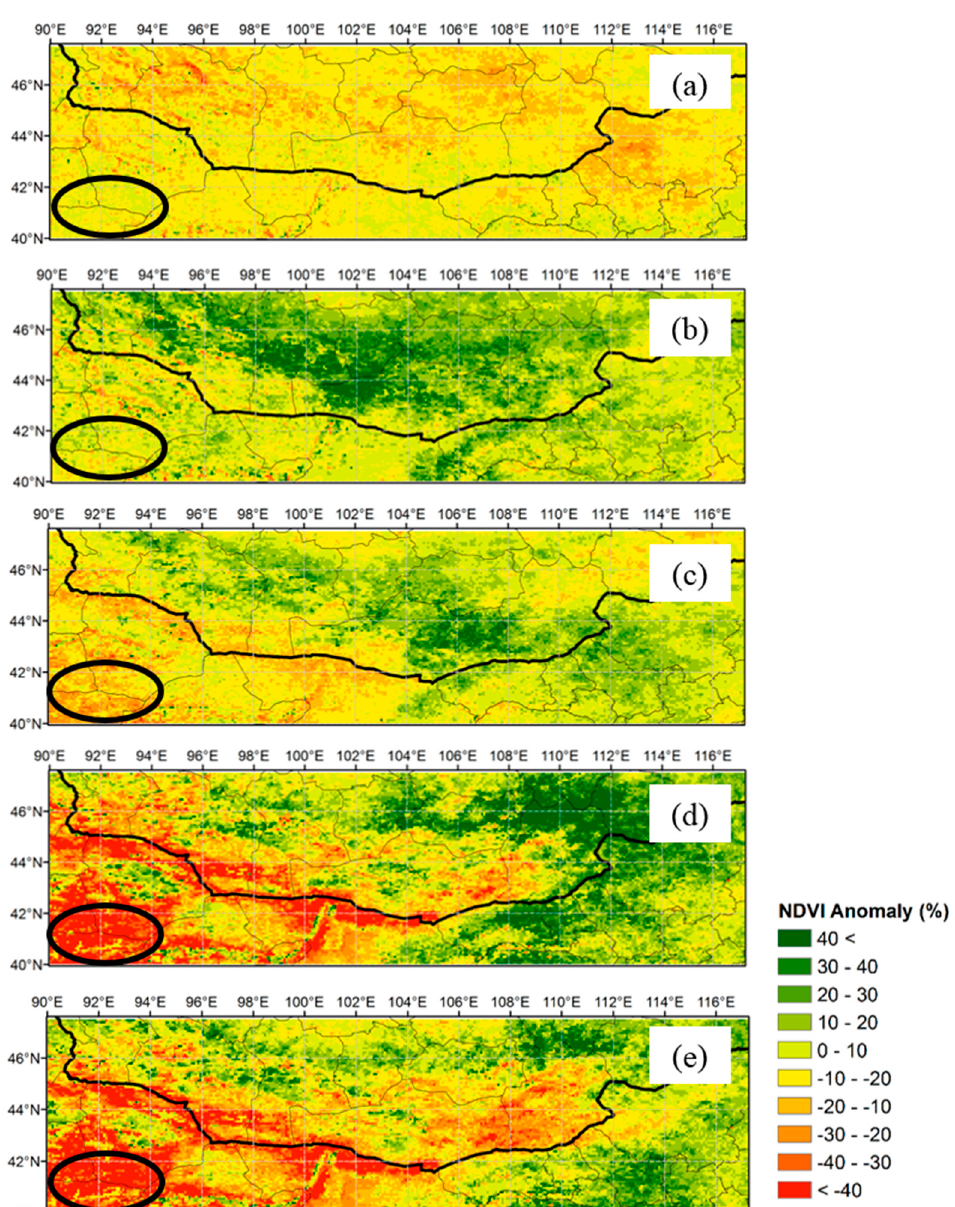
Figure 11. Anomaly NDVI in GS in ( a ) 1989; ( b ) 1994; ( c ) 2003; ( d ) 2012 and ( e ) 2013 [31].